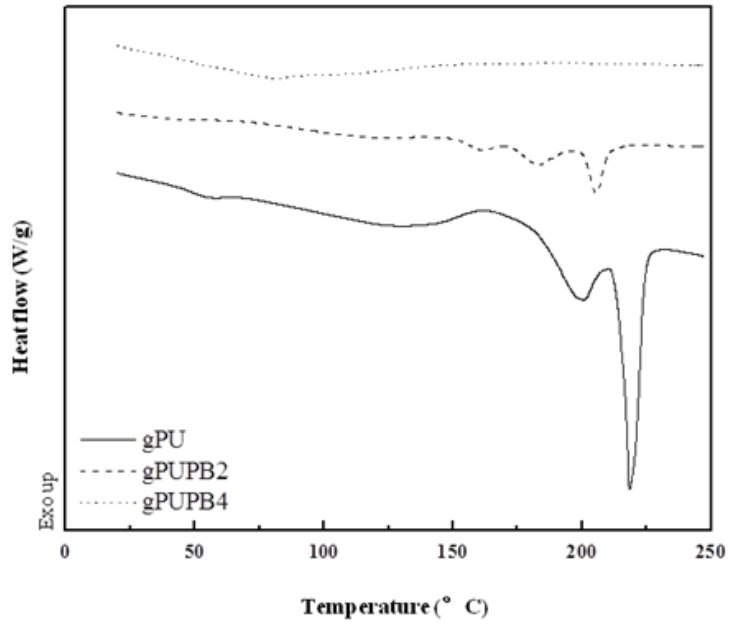
Figure 2. DSC traces of PU with amorphous soft-segment and its compounds with PB. The compounds were cured at 180 °C. Scan rate was 10 °C min − 1